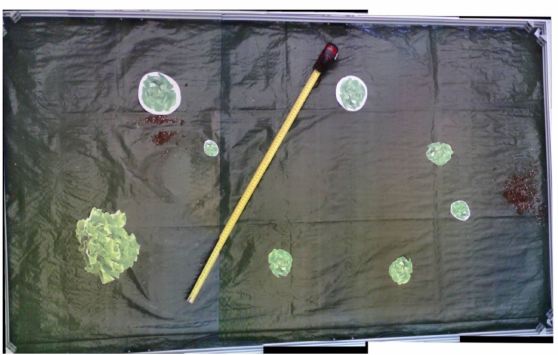
Figure 15. Example of a stitched image.